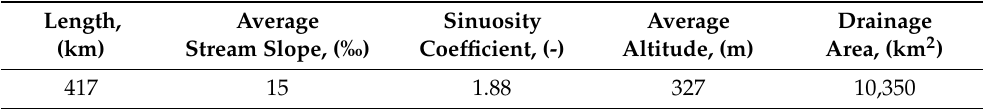
Figure 5. The Ialomita River location—Tandarei hydrometric station. Table 4. The morphometric characteristics.